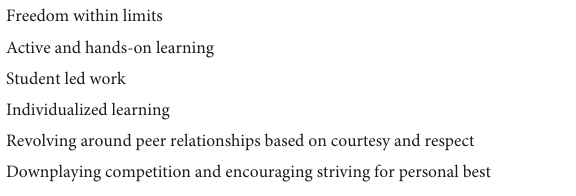
TABLE 2 Montessori principles.